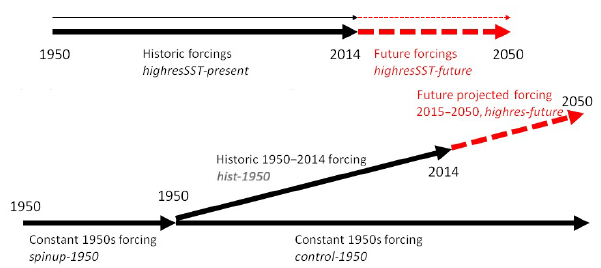
Figure 5. Schematic representation of the HighResMIP simula-